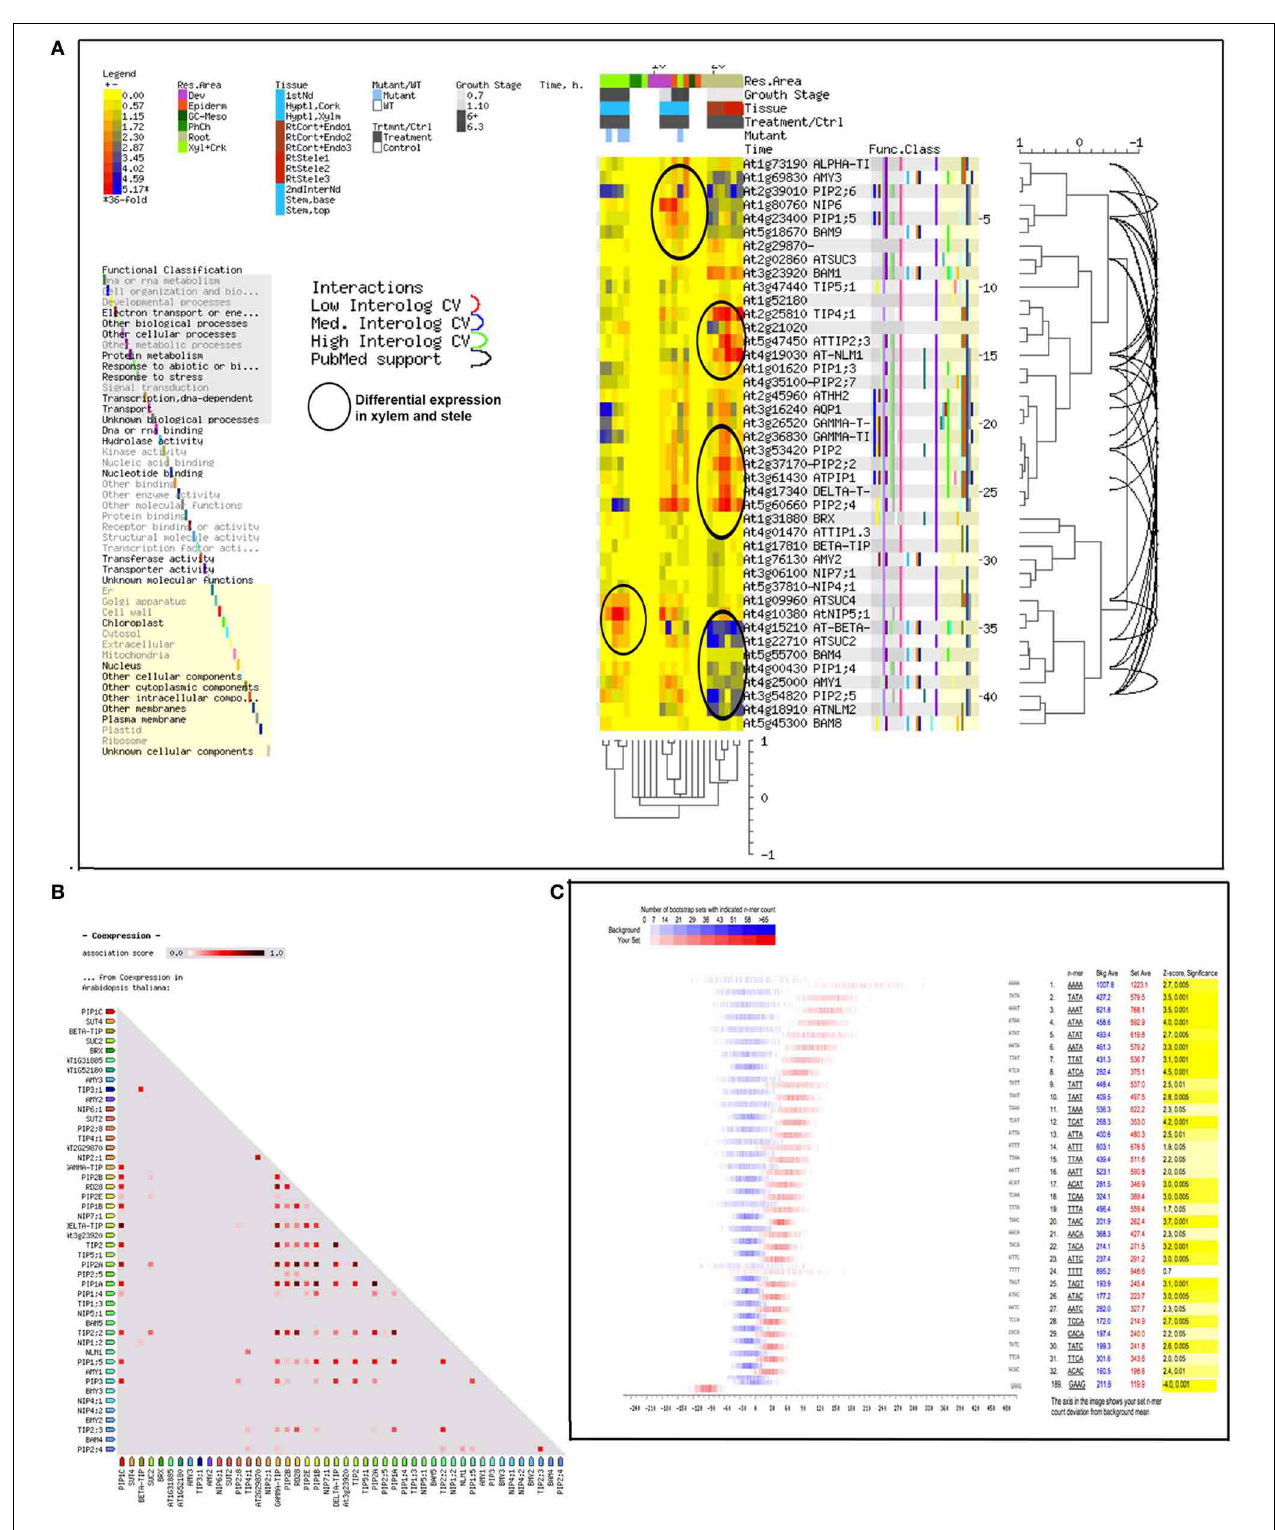
FIGURE 4 | (A) Localization of the genes from Tables 1 , 2 in various Arabidopsis tissue, from public microarray databases, and e-northern tool at Botany Array Resource (Toufighi et al., 2005). (B) Co-expression profile of the genes in Arabidopsis (Szklarczyk et al., 2010). (C) Distribution of relevant